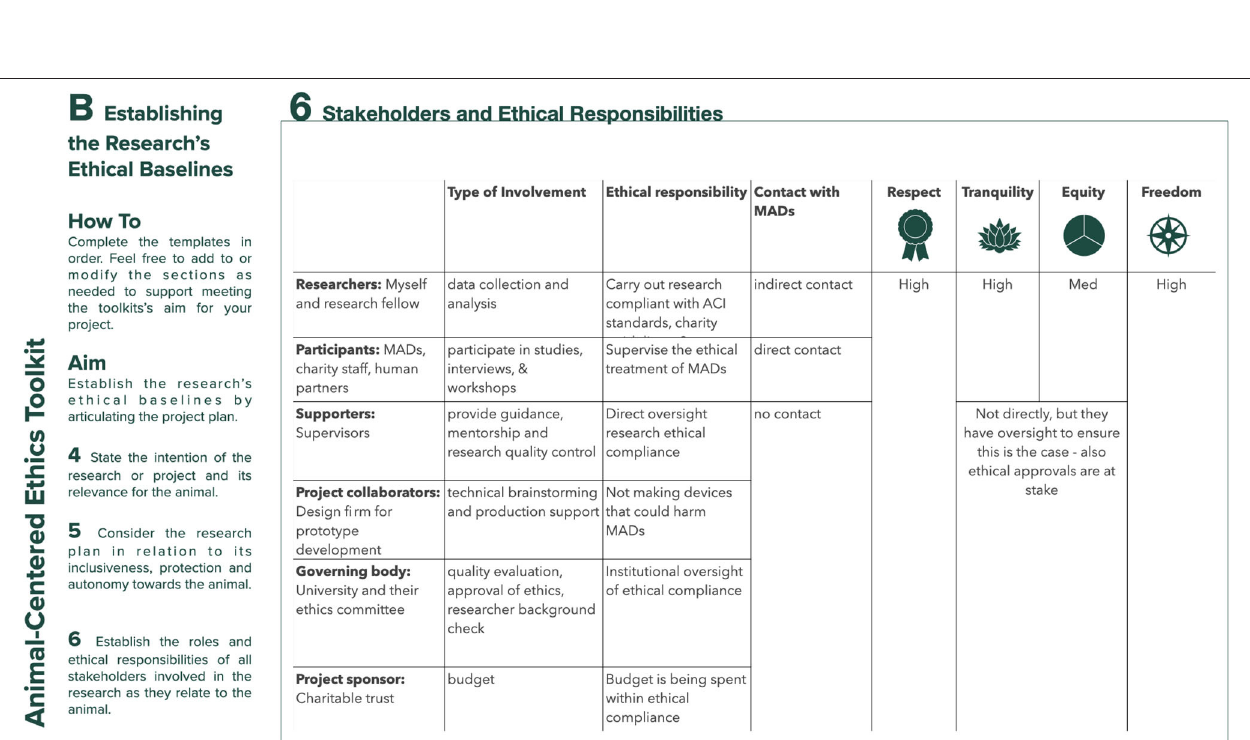
Frontiers in Veterinary Science |